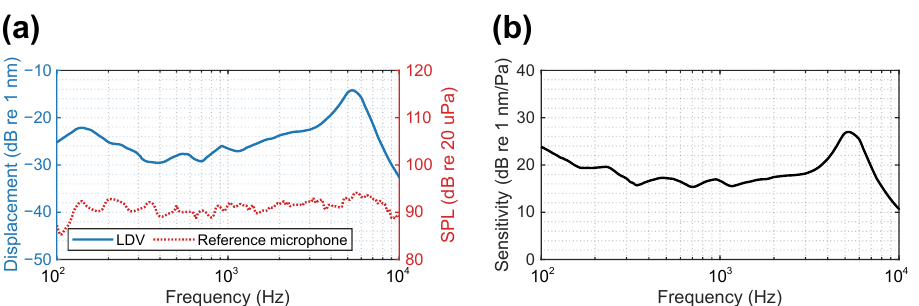
Figure 6. ( a ) Spectrum of the membrane displacement from the LDV and the SPL by the reference microphone and ( b ) the corresponding sensitivity of the membrane as in displacement with respect to SPL monitored by the reference microphone.